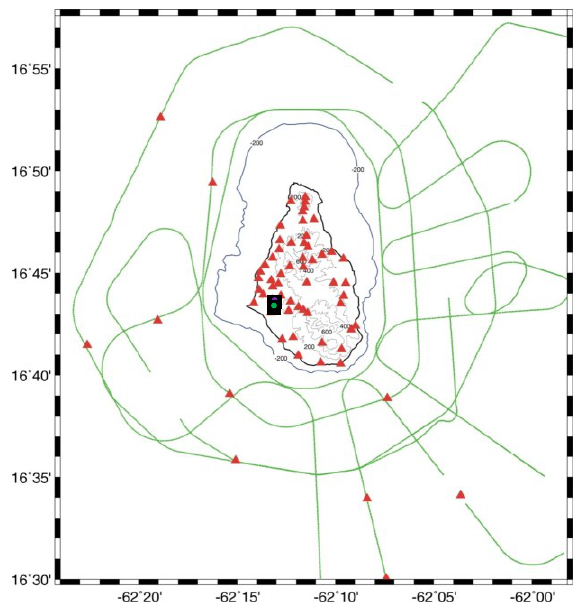
Figure A3. Location of seismometers (red triangles) used in this study located on-island and off-shore. The green line indicates the track of the vessel towing the air-gun seismic source. The green and purple dots mark the positions of wells MON-1 and MON-2, respectively. The blue outline surrounding the island indicates the extent of a shallow submarine